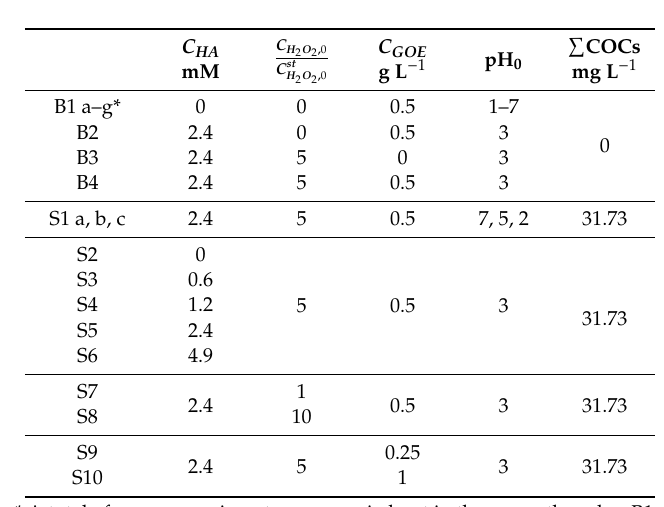
/ C st ), goethite H 2 O 2 ,0 2 O 2 ,0